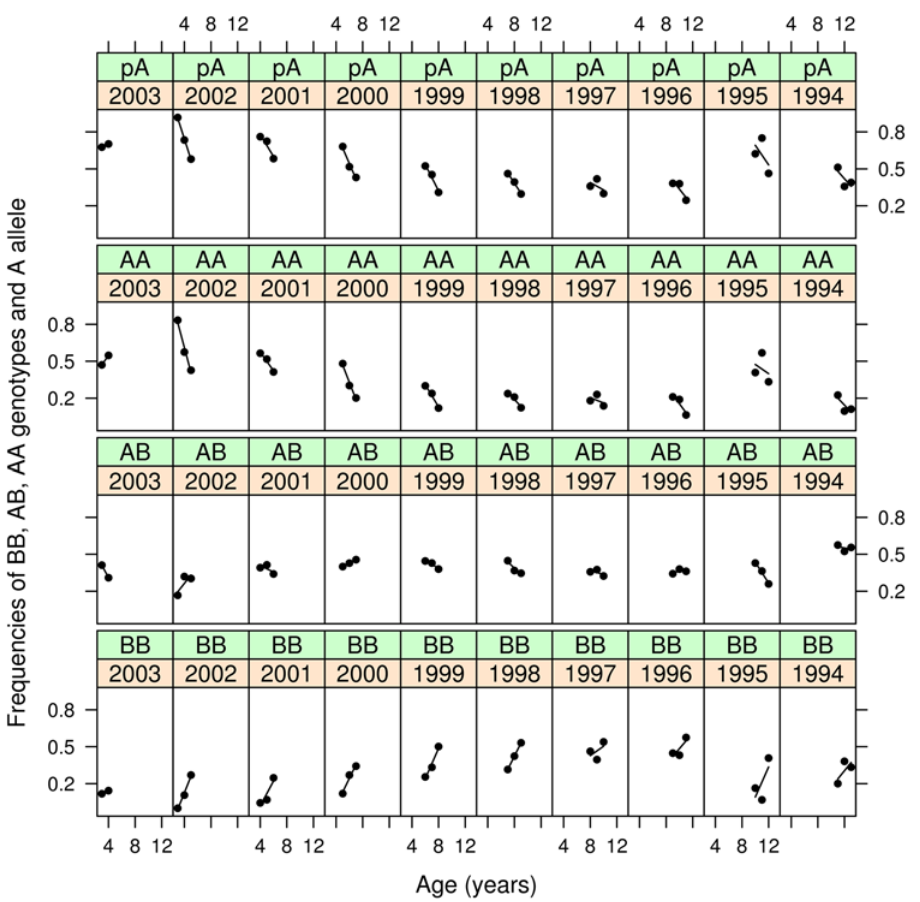
Figure 5. Allelic and genotypic frequencies at age conditioned on year class. Spring spawning Atlantic cod at Iceland. Frequency of A allele, p A (top panel row), and frequencies of AA , AB , and BB genotypes, f AA , f AB , and f BB (panel rows 2–4 respectively). Panels represent year classes arranged most recent to older from left to right in each row. Points N represent observed frequencies; lines represent linear regression of frequency on age.